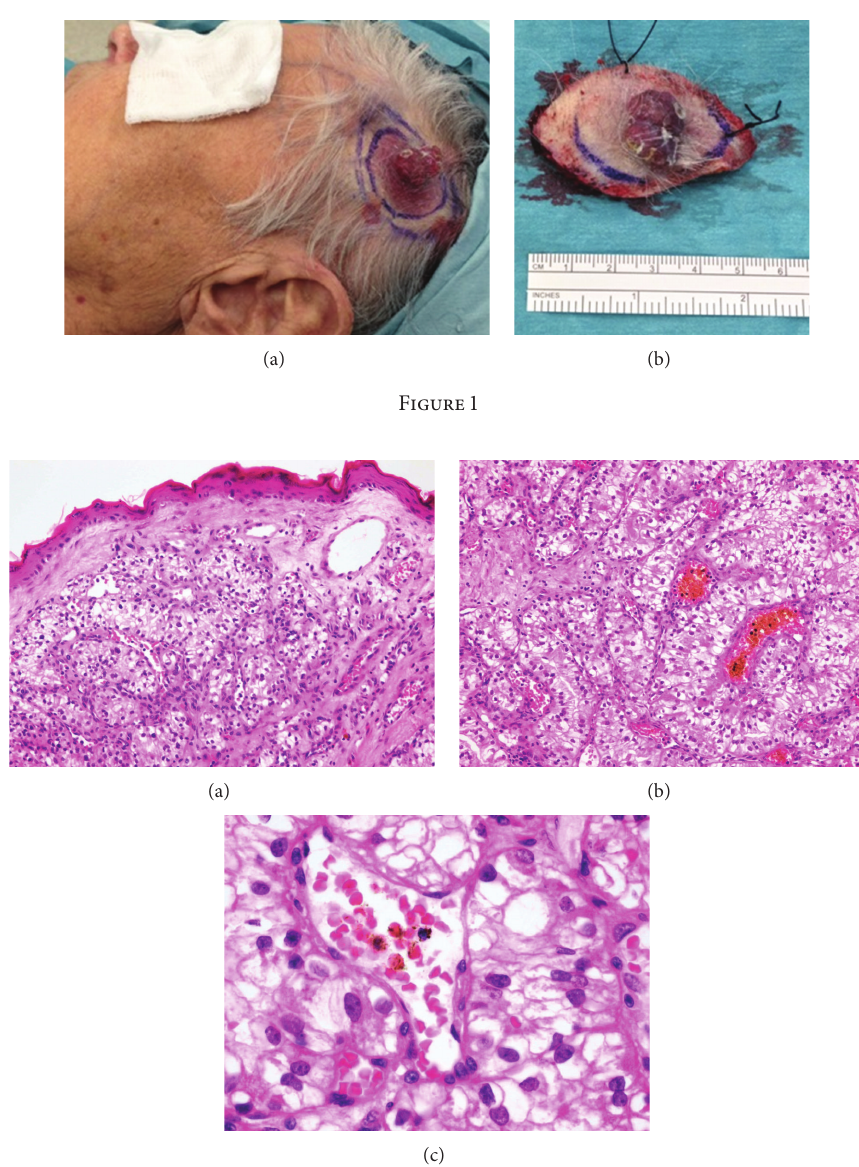
Figure 2: (a) × 40 magnification: the skin shows a tumour beneath the epidermis composed of clusters of clear cells and a rich vascular stroma; (b) × 100 magnification: tight nests of clear cells separated by thin richly vascular fibrous septa; (c) × 400 magnification: typical renal cell carcinoma cells with occasional prominent